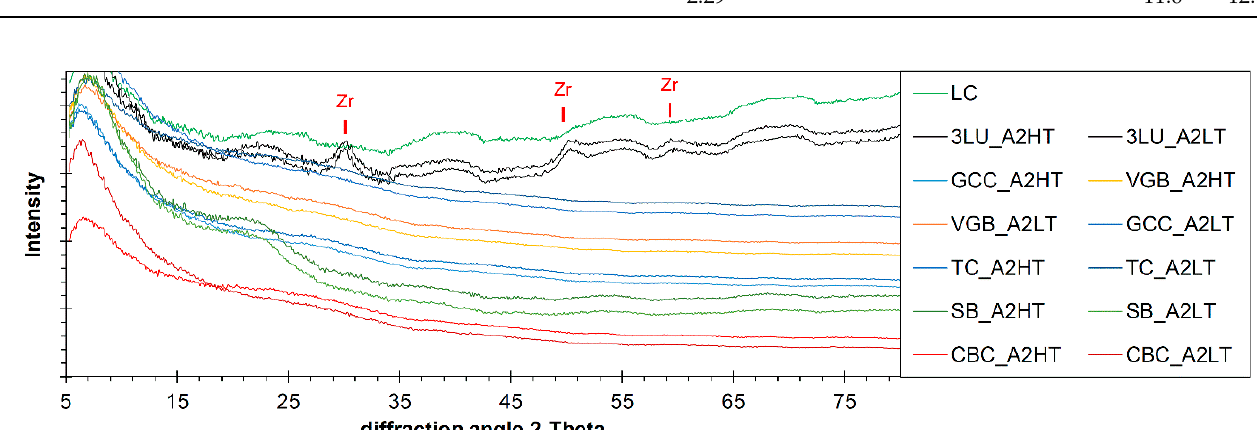
Figure 5. XRD patterns of the filler particles in the various CAD/CAM RBCs (3LU-Lava Ultimate, CBC-BRILLIANT Crios, GCC-Cerasmart, LC-LuxaCAM Composite, SB-Shofu Block HC, TC-Tetric Cad, VGB-Grandio blocs); only in 3LU samples crystalline phases could be detected—in this case zirconia (Zr).